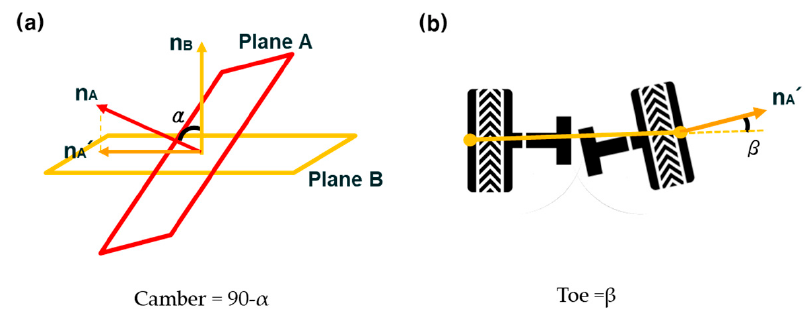
Figure 4. Camber and toe angles from Planes A and B. ( a ) Camber angle. ( b ) Toe angle.